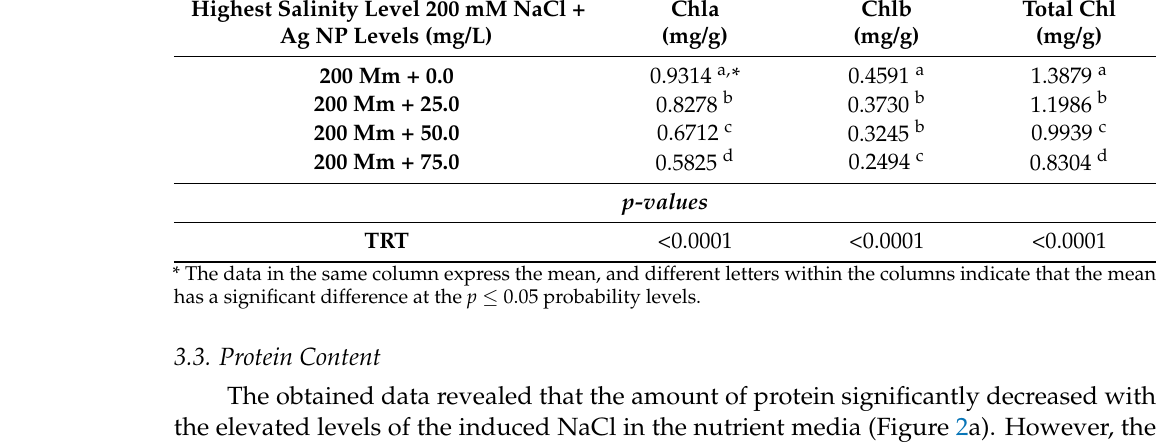
Table 4. Chlorophyll content of the Q6 quinoa plantlets grown under the highest NaCl level after adding different levels of Ag NPs.